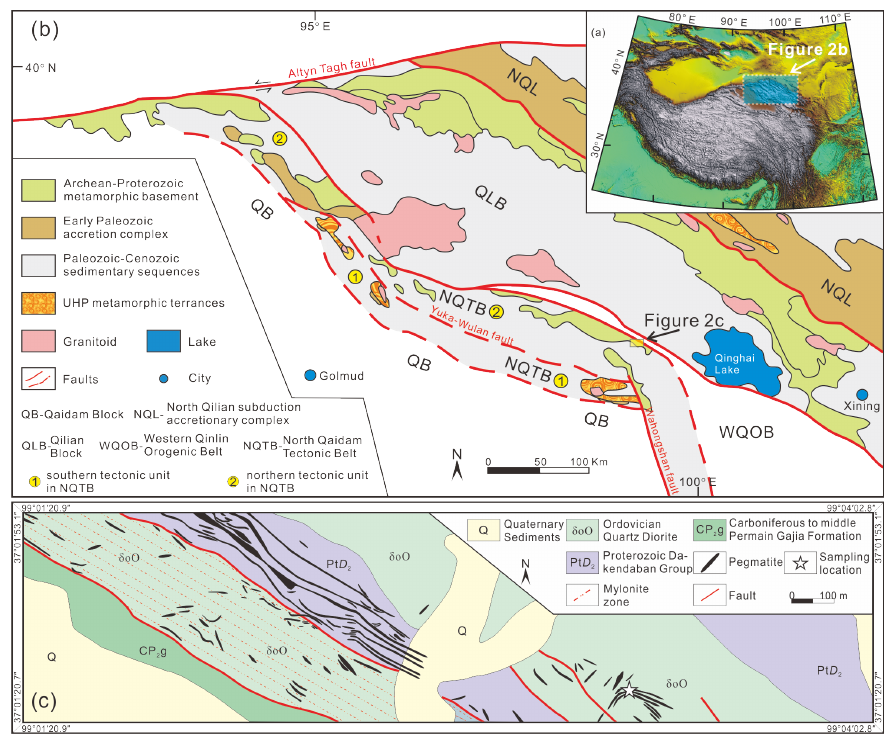
Figure 2. ( a ) Topographic map showing the location of Figure 2b; ( b ) Geological sketch of the NQTB and its surrounding tectonic units (modified after Chen et al. [34], Li et al. [35] and Ren et al. [36]); ( c ) Geological sketch showing the typical area of the CKBS Li-Be deposit and sampling loca- tion (modified after 1:10,000 geological survey data). The CKBS deposit is the first pegmatite-type Li-Be deposit discovered in the eastern